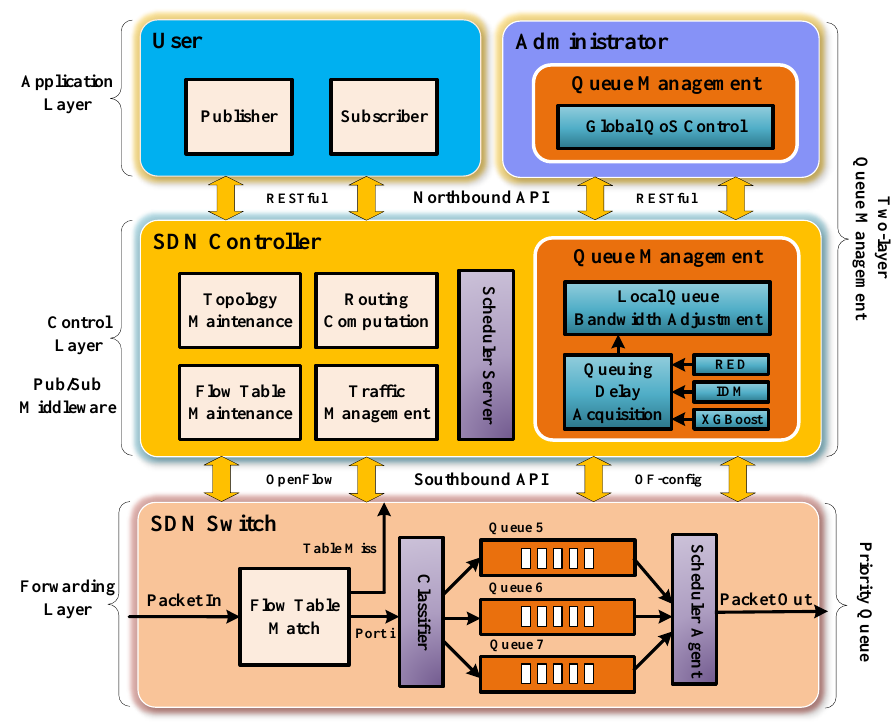
Figure 3. Two-layer queue management